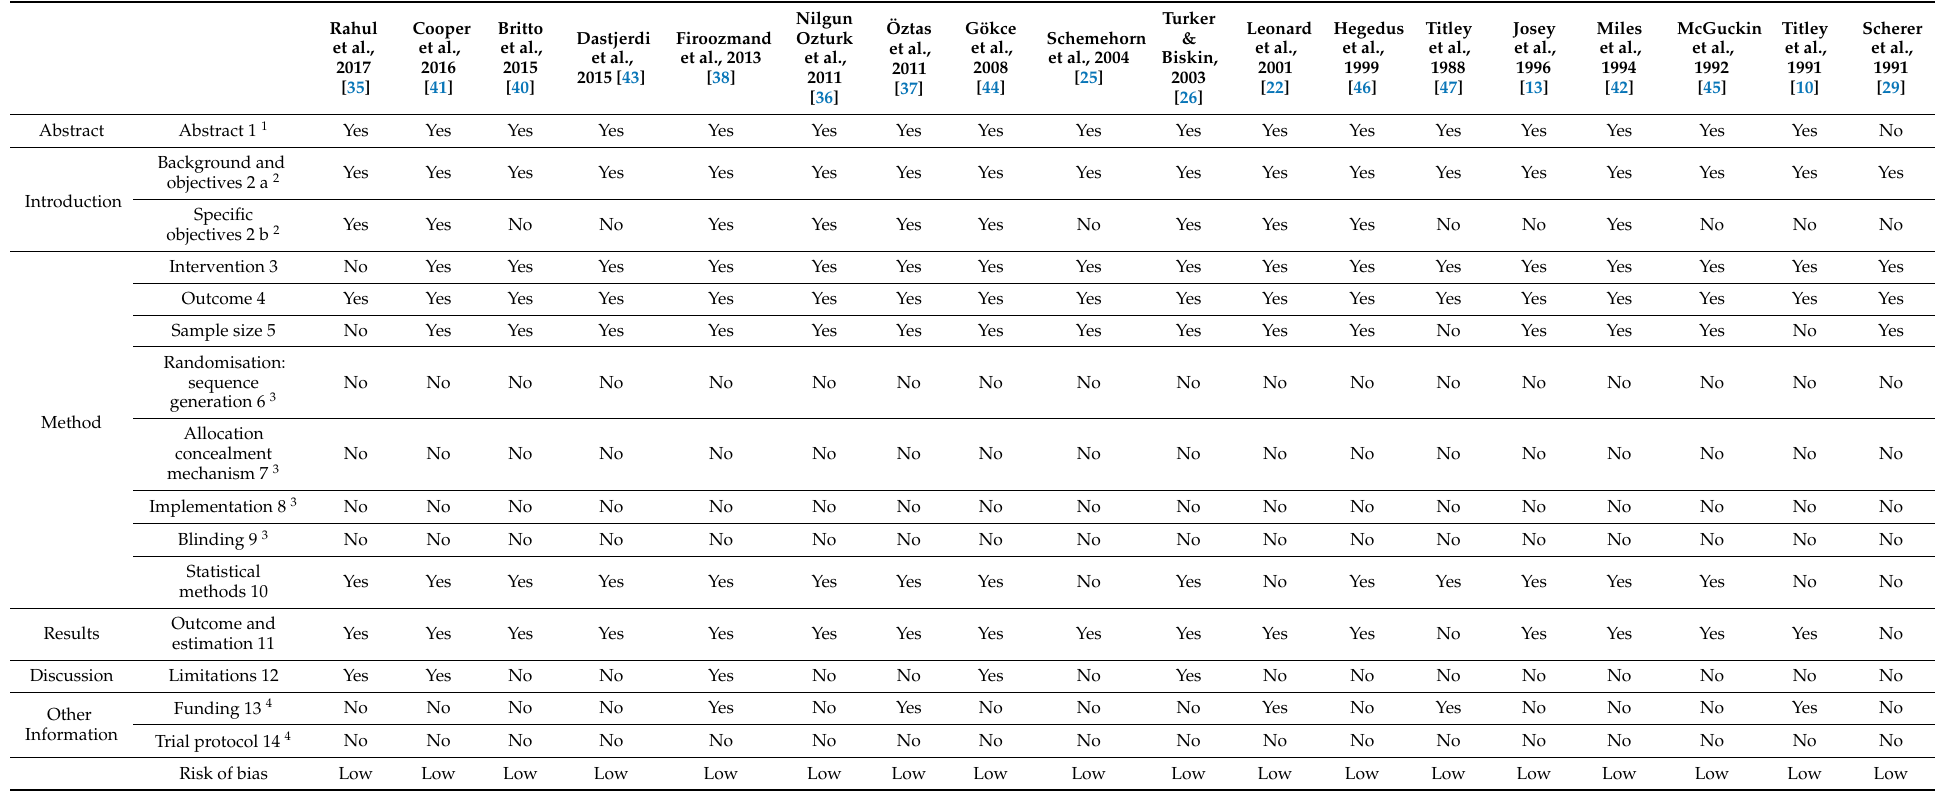
Table 5. Risk of